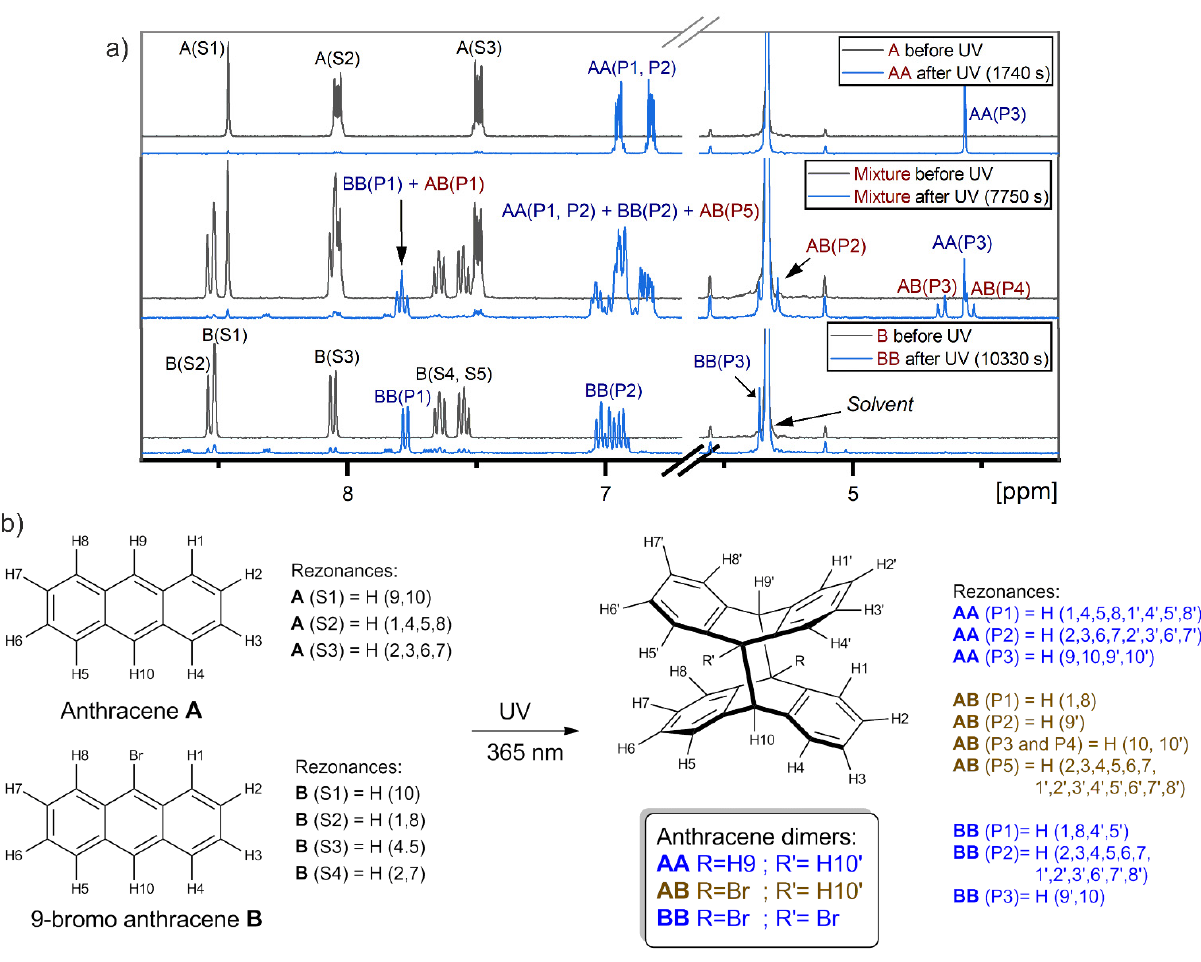
Figure 7. ( a ) The comparison of 400 MHz 1 H-NMR spectra of 2.25 mM of pure anthracene ( A ) (at the top), 2.25 mM of pure 9-bromoanthracene ( B ) (at the bottom) and their mixture (in the middle) before (upper black spectrum) and after (lower blue spectrum) UV illumination ( λ = 365 nm) as well as ( b ) the assignment of the spectral lines. S1–S5 and P1–P5 represent spectral lines of substrate and product respectively. AA , BB and AB correspond to the dimer of anthracene, dimer of 9-bromoanthracene and dimer of anthracene and 9-bromoanthracene, respectively. Samples were prepared in deuterated CD 2 Cl 2 in the glove box.